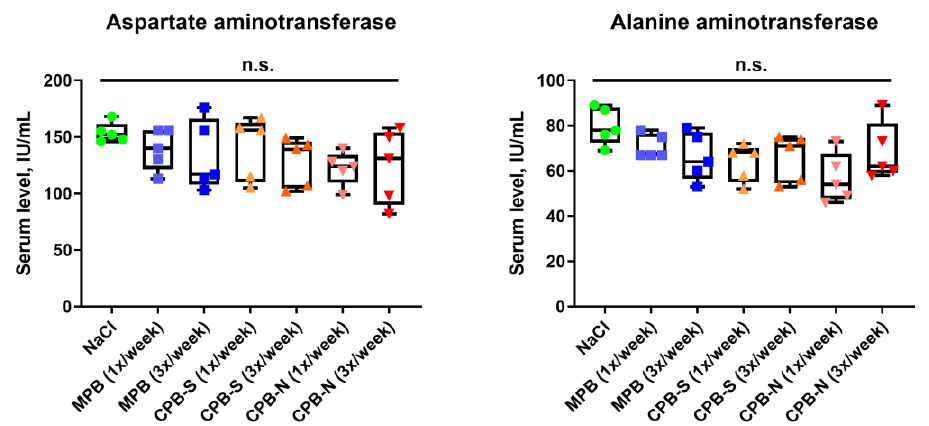
Figure 4. Quantification of serum transaminases in Wistar rats treated with NaCl, MPB, CPB-S, or CPB-N according to the indicated protocol. Box-and-whisker plots combined with a univariate scatterplot, where each dot represents a serum sample collected from one rat. Whiskers indicate range, box bounds indicate the 25th and 75th percentiles, and center lines indicate the median. Dunn’s multiple comparisons test, n.s. is for